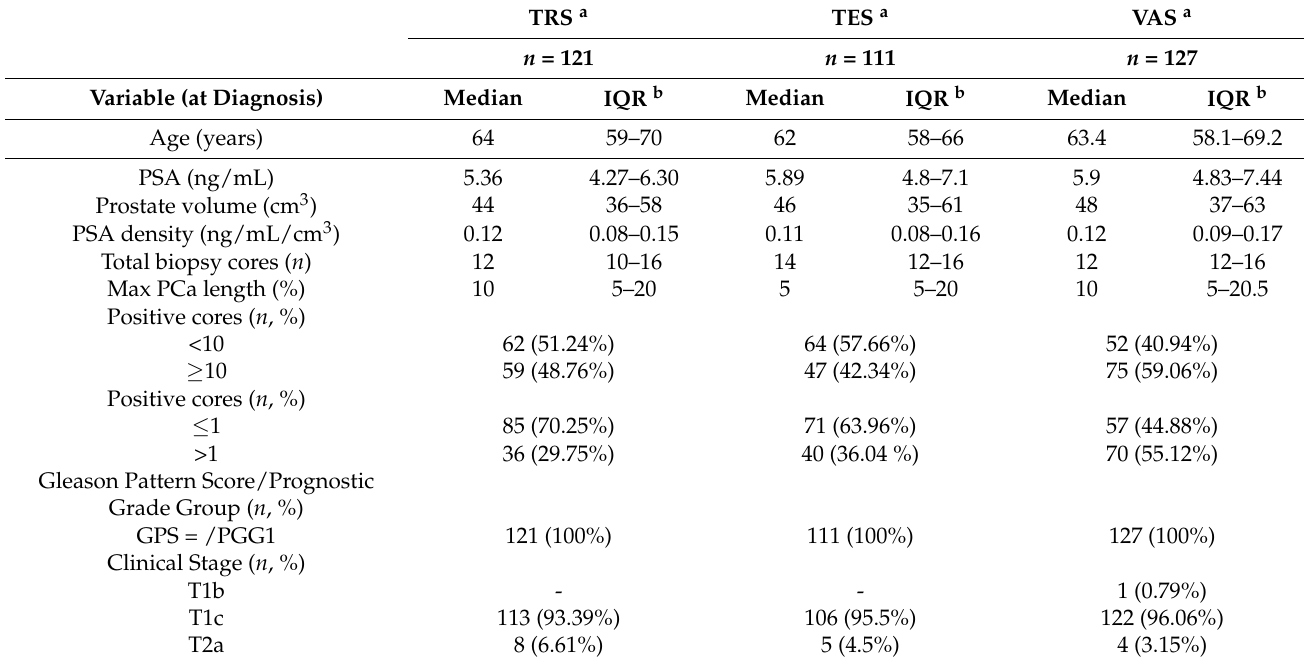
Table 1. Clinicopathological characteristics of patients in the three AS cohorts.